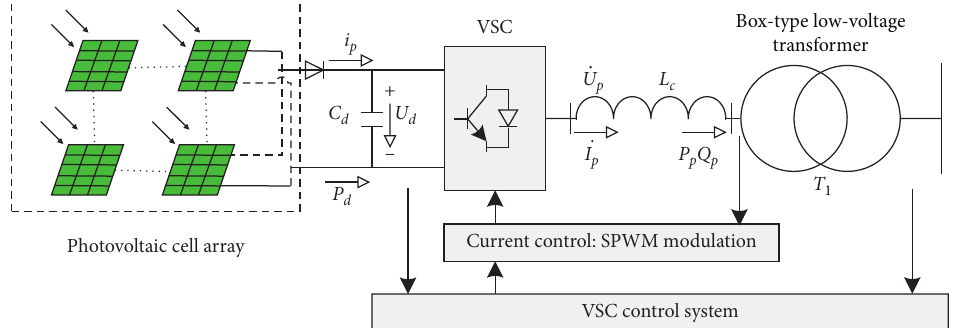
Figure 1: Topology of photovoltaic power generation unit.